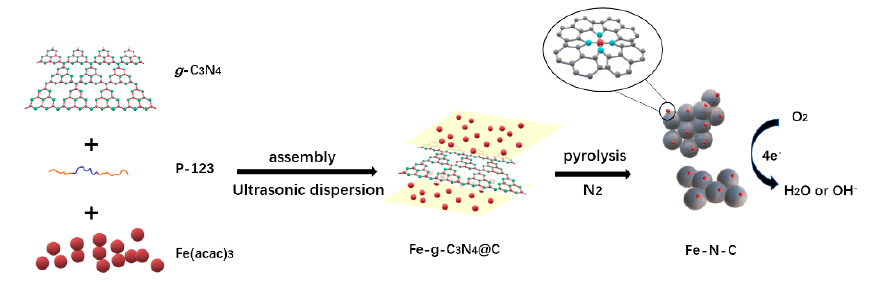
Figure 1. Schematic synthetic strategy.